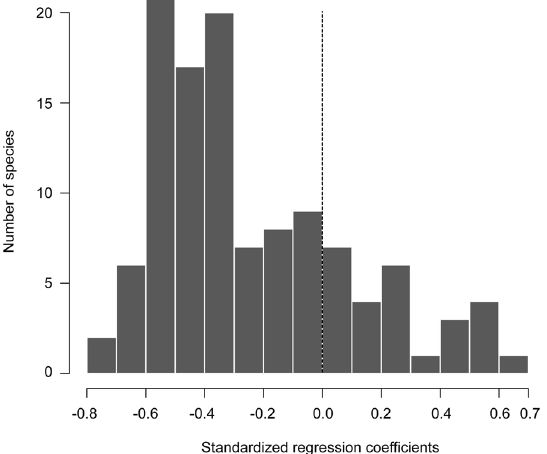
Figure 1. Distribution of standardized regression coefficients of seasonal catches of 116 fish species recorded at the Dai fishery, Tonle Sap River from the fishing season of 2000/01 to